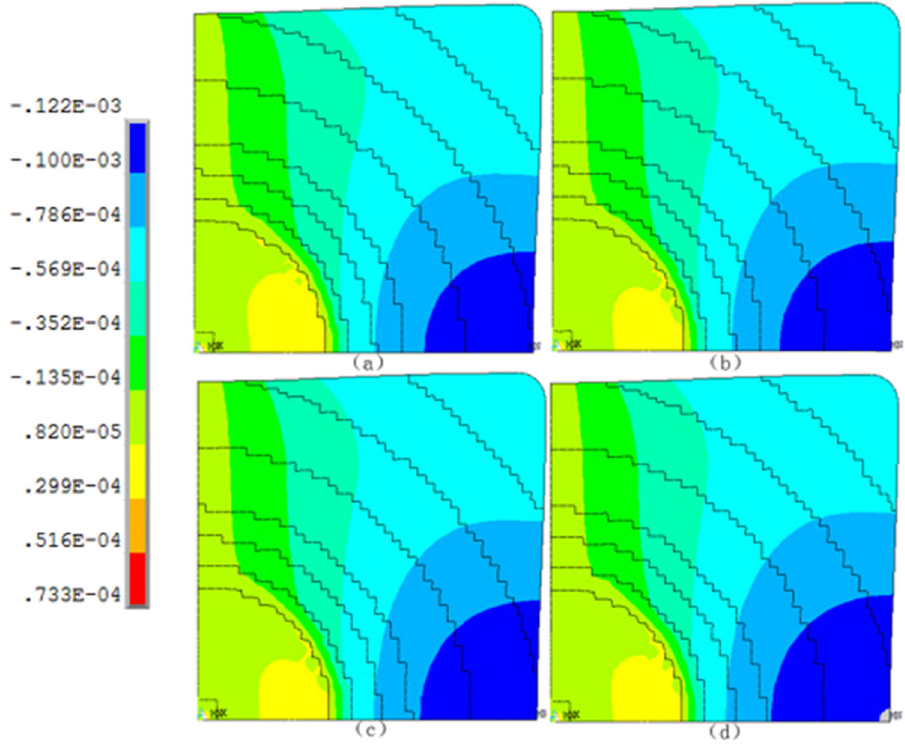
Figure 6: Cloud diagram of displacement distribution under di ff erent superheat: ( a ) 10°C, ( b ) 20°C, ( c ) 30°C, and ( d )